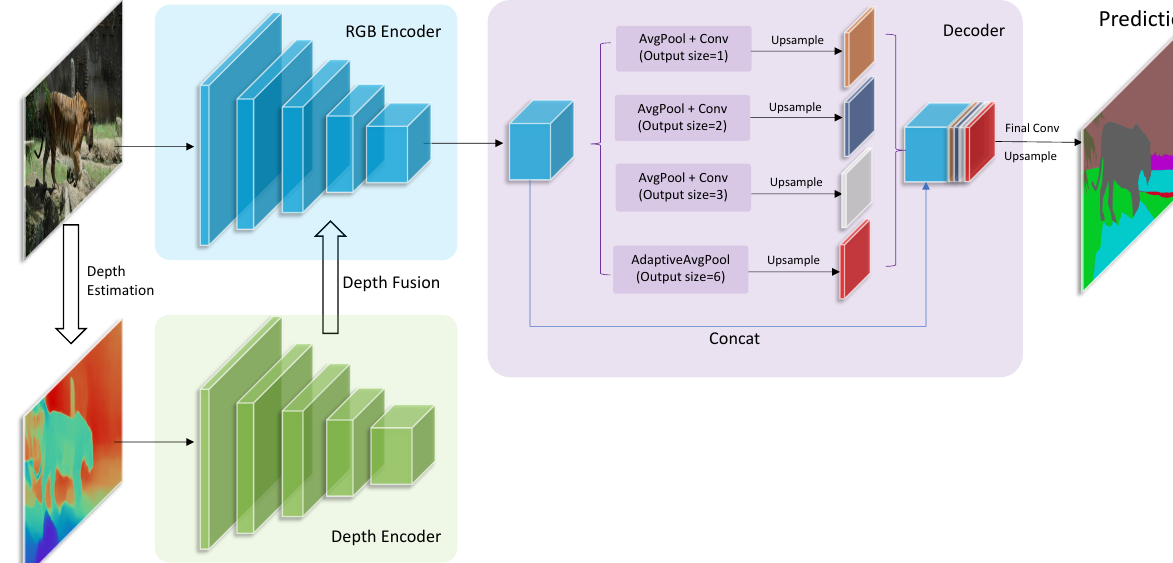
Figure 2. The detailed architecture of our proposed network. The inputs are an RGB image and its corresponding depth map. They are separately fed into two encoders. Then, depth features are fused into RGB features step by step. The fused features are fed into the decoder that consists of a PPM [81] module. At last, the decoder outputs the prediction of semantic